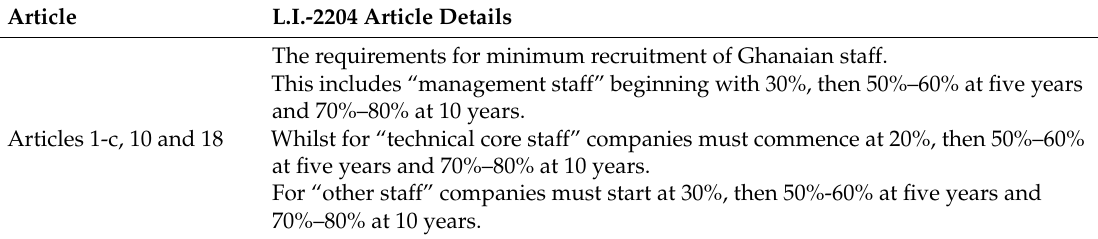
Principal L.I.-2204 articles focused on employing Ghanaians (source: Petroleum Commission,